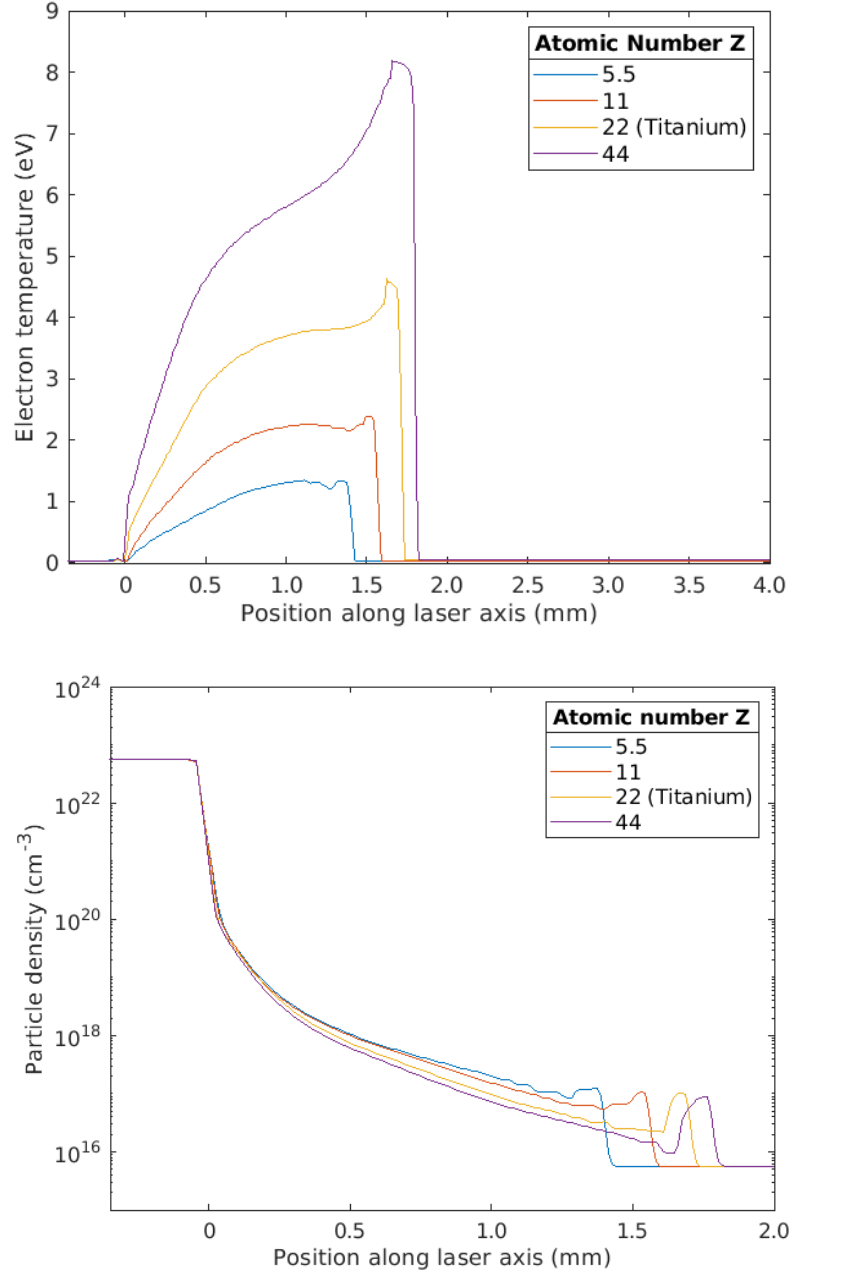
Figure 4. 1D plot comparing the spatial distribution of the electron temperature (top) and the particle density (bottom) of an ablated titanium plasma plume with varied atomic number 25 ns after the laser pulse. The default atomic number of titanium is 22. The laser fluence was 100.5 J cm − 2 and the laser focus was 100 µ